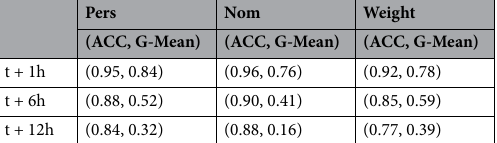
Table 6. Accuracy and G-Mean classification scores obtained for the models at three different forecast horizons.